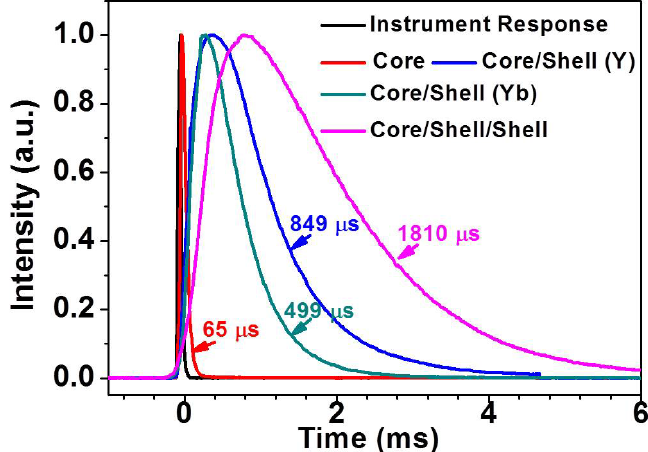
: 30%Yb 3+ , 0.5%Tm 3+ )/NaYF 4 , and the active core/active 4 /NaYF 4 4